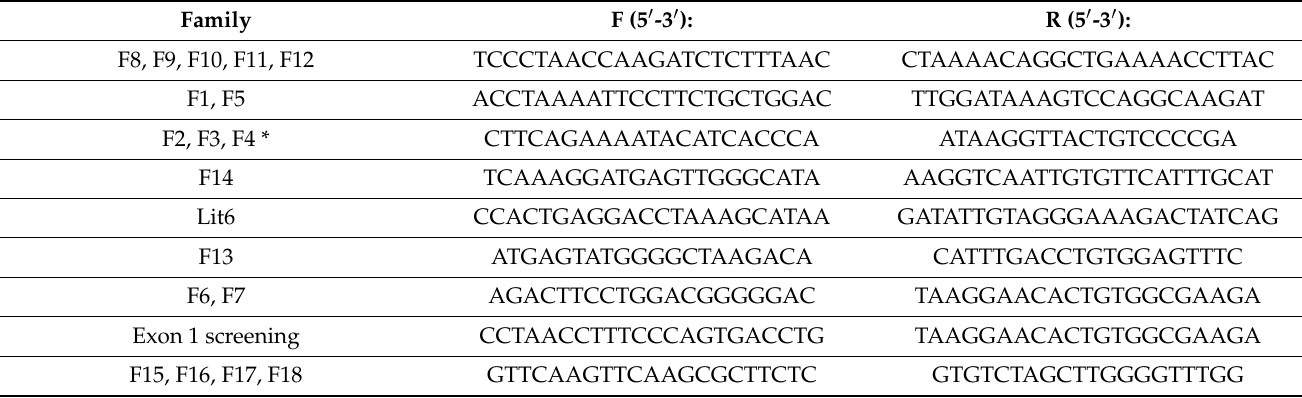
Table 1. Primers used in the characterization of the detected deletions and in the screening of the exon 1 locus.